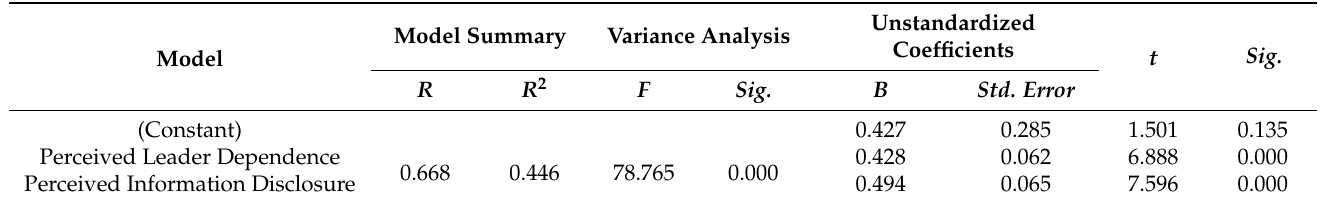
Table 12. Regression Analysis of Perceived Leader Trust on Employee Relationship Performance.